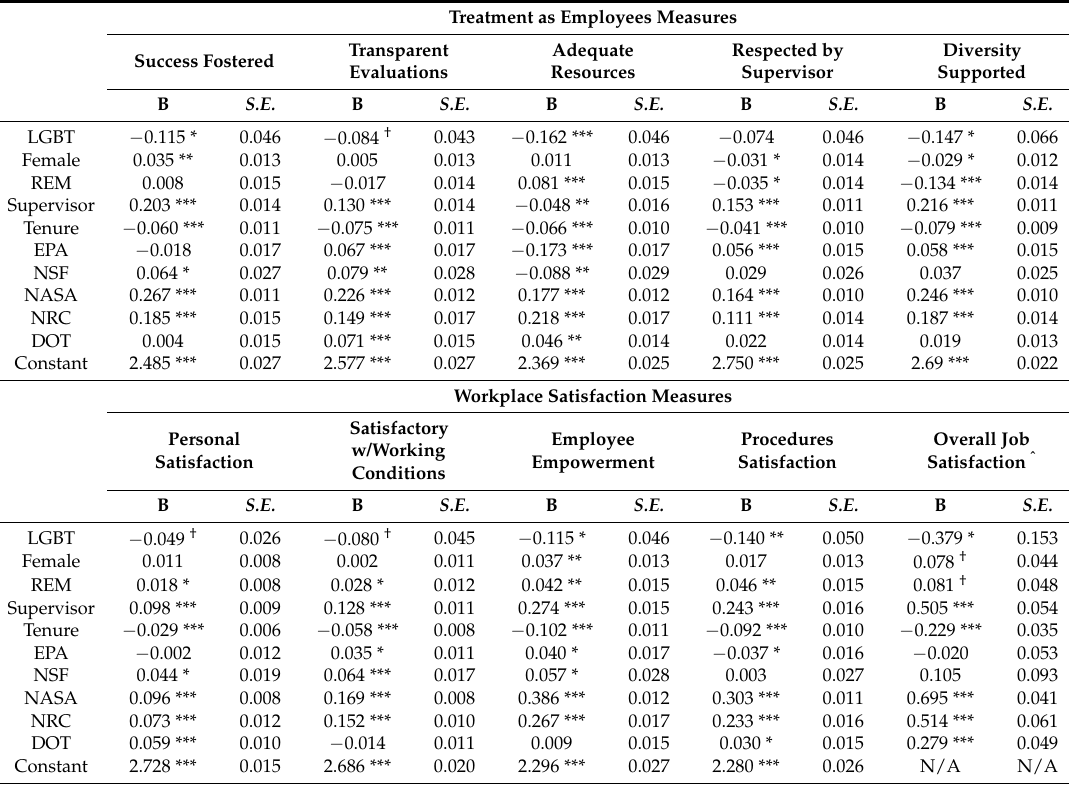
Table 3. OLS and Ordered Logistic Regression Models Predicting Workplace Experience Measures with LGBT Status and Controls (N =